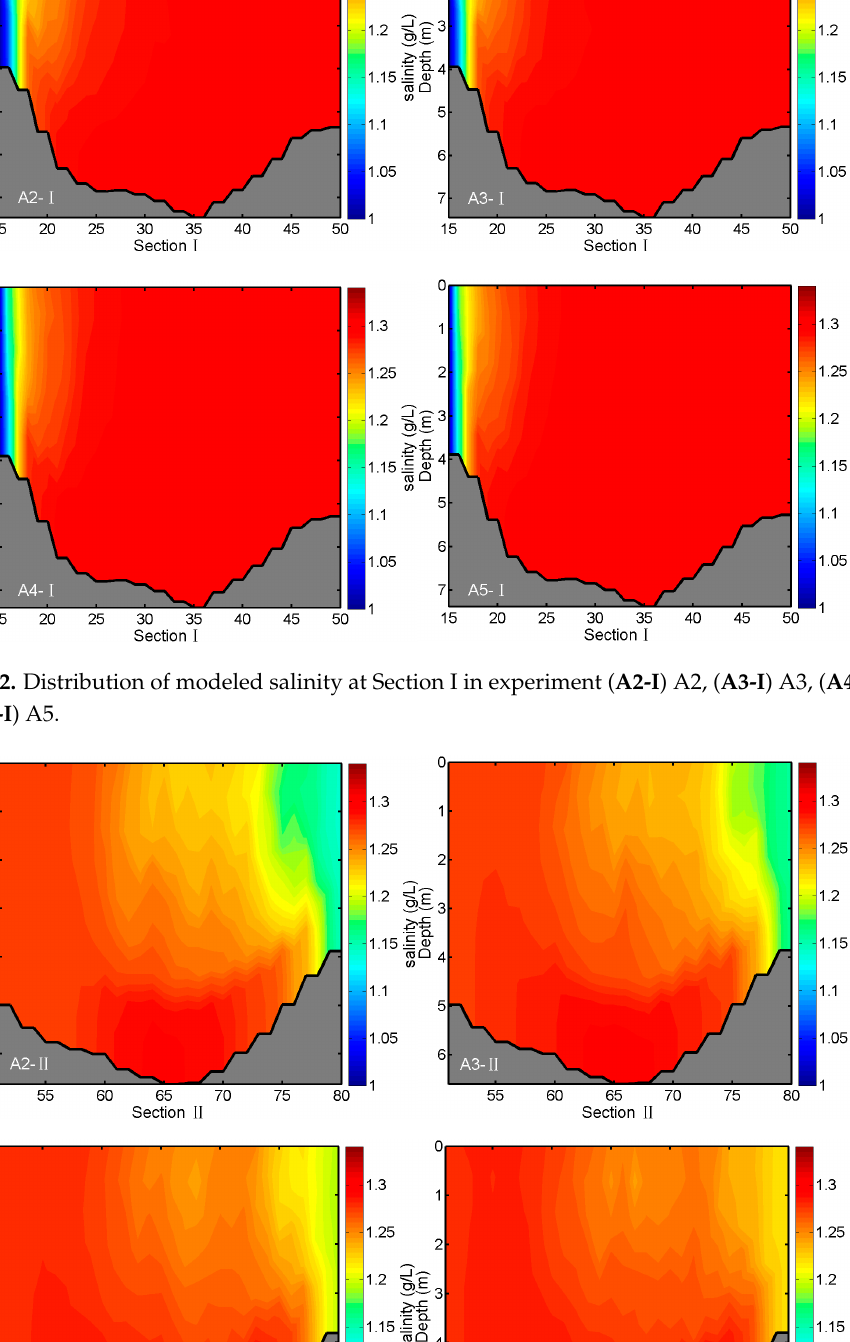
Figure 11. The Salinity average absolute differences (AAD) distributions between experiments at surface ( A3-A2.S ) A3-A2, ( A1-A2.S ) A1-A2, ( A4-A2.S ) A4-A2, and ( A5-A2.S ) A5-A2, and at the